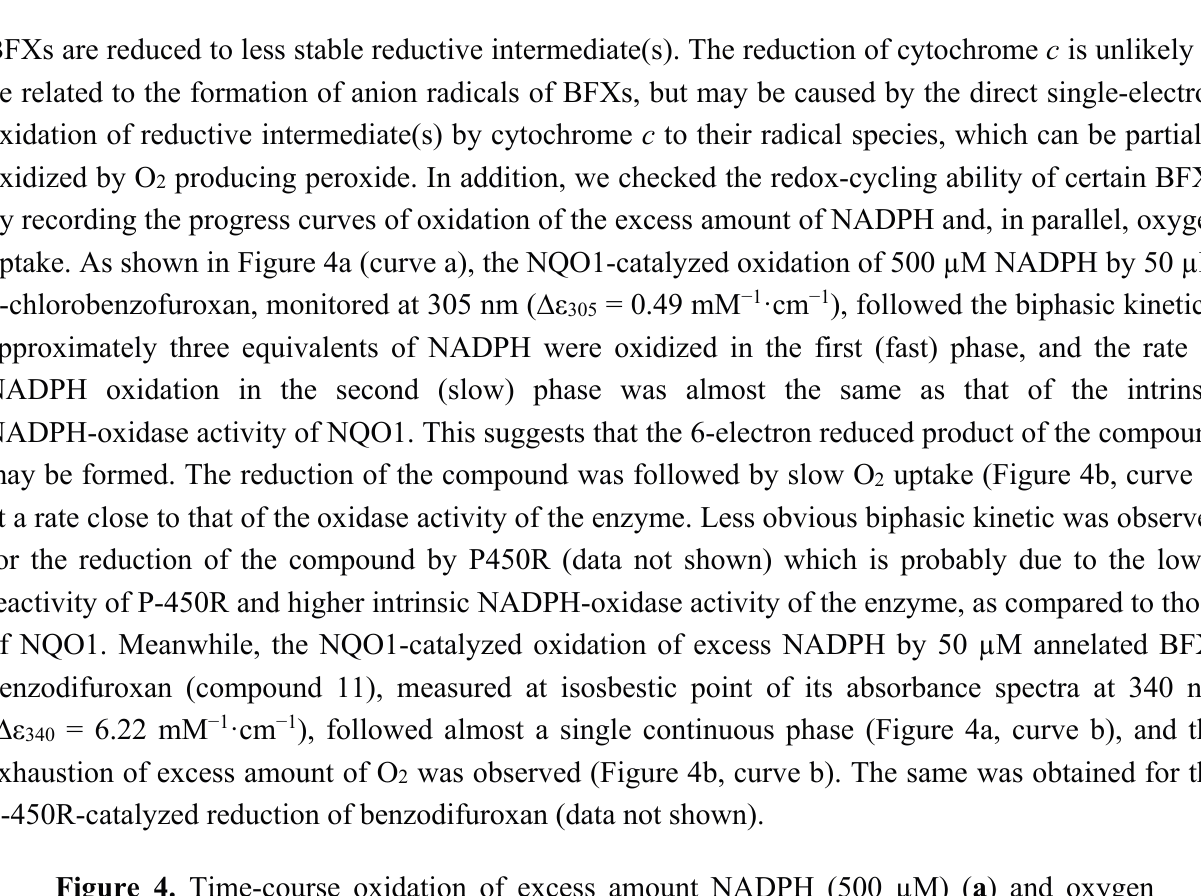
Figure 4. Time-course oxidation of excess amount NADPH (500 µM) ( a ) and oxygen uptake ( b ) during the NQO1-catalyzed reduction of 50 μ M 5-chlorobenzofuroxan (curve